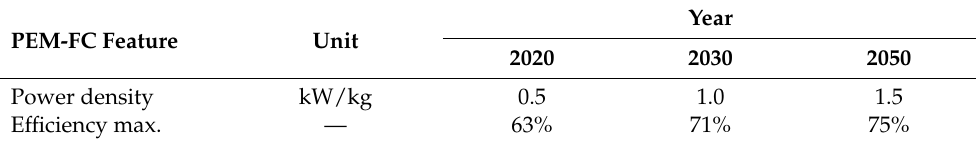
Table 7. The expected increase in FC power density and efficiency.